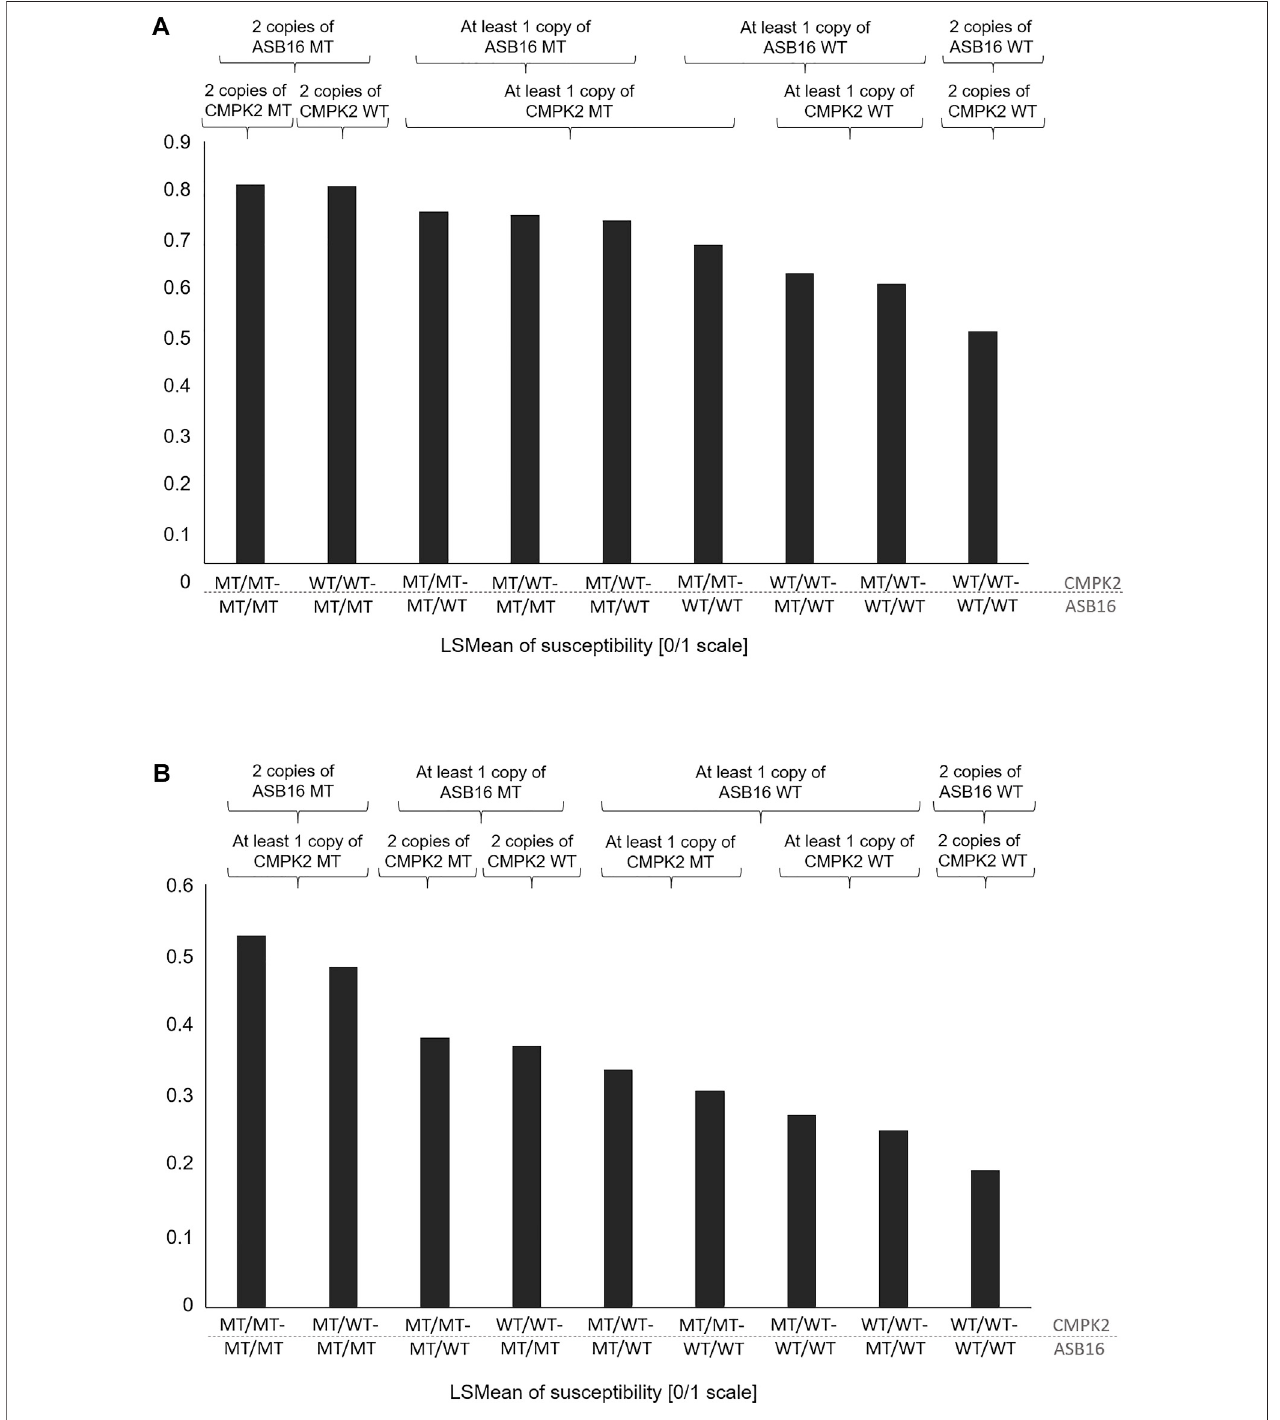
FIGURE 5 | LSMeans of the disease status for combinations of genotypes rs208894039 ( CMPK2 ) ( fi rst part of the genotype name) and rs109521151 ( ASB16 ) (secondpart ofthename). (A) LSMeans ranked bythevaluefrom thehighest tolowestfor phenotype TBIN. (B) LSMeans ranked bythevaluefrom thehighest tolowest for phenotype TCHRONA. WT/WT: homozygous for the reference allele; MT/MT: homozygous for the alternative allele.